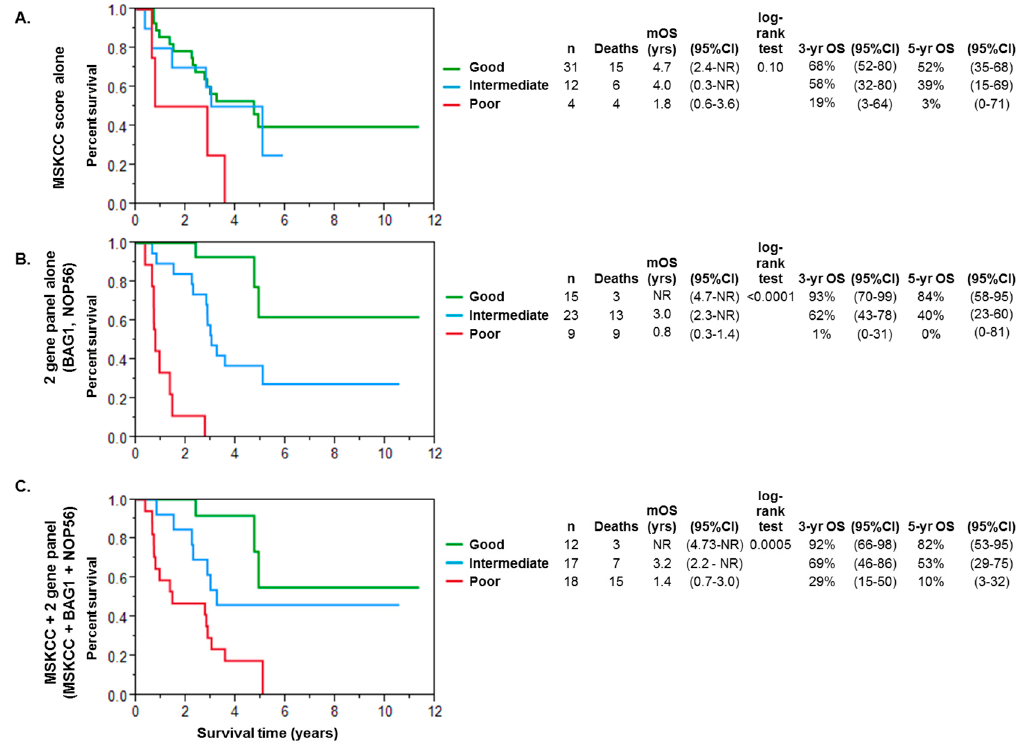
Figure 2. Kaplan–Meier survival analyses were generated from time of metastases to death or last follow-up in 3 scenarios: ( A ) using MSKCC score alone; ( B ) using the 2-gene panel alone at cutoffs specified in Table 2; or ( C ) the MSKCC score incorporating the 2-gene panel to identify good, intermediate, and poor risk categories. The number in each prognostic category, median overall survival (mOS) in years, 95% confidence intervals (CIs), log-rank test p -value, 3-year OS and 5-year OS for each scenario is are displayed in the adjacent table. NR = not reached. “n”-number of patients.